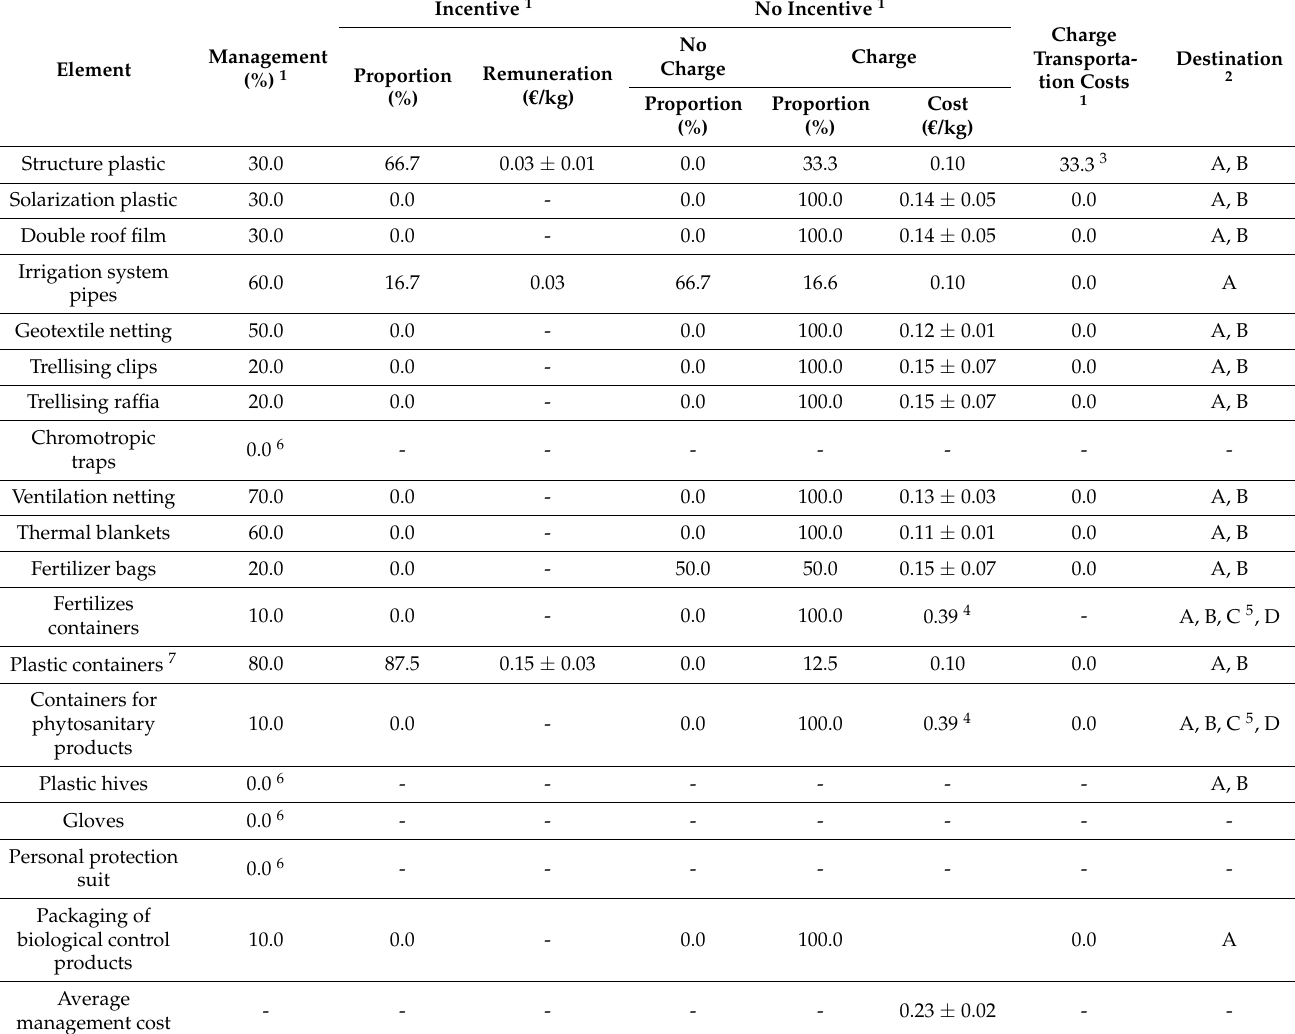
Table 4. Management offer, incentive system, and possible treatments of waste/by-products in the Almeria model (n = 10).